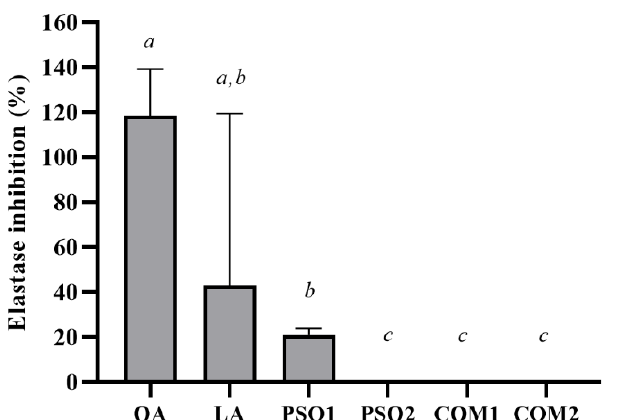
Figure 7. Elastase inhibitory effect of pumpkin seed oil samples (PSO1, PSO2, COM1, COM2), linoleic acid (LA), and oleanolic acid (OA). Data obtained from triplicate and three independent experiments are expressed as mean ± SD. The letters a , b and c presented significant differences among samples in each experiment, p < 0.05.